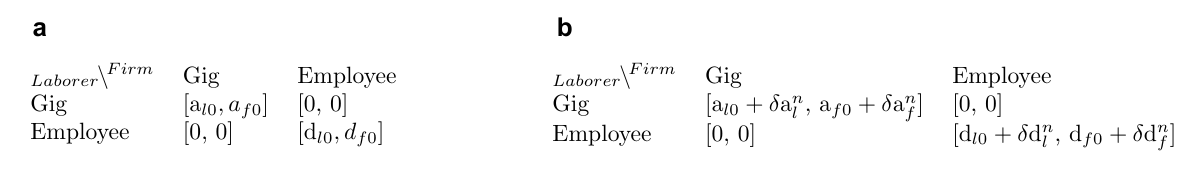
Figure 9. n = 1 payoffs represented in terms of n = 0 payoffs. ( a ) Bear market, n = 0. ( b ) Bull market, n = 1. We rephrase bull market payoffs in terms of bear market payoffs and a market δ , which captures how labor preference varies from a bear to bull market. For simplification purposes, we assign all mismatching strategies a payoff of 0 as no mutual labor agreement is made between firm and laborer.